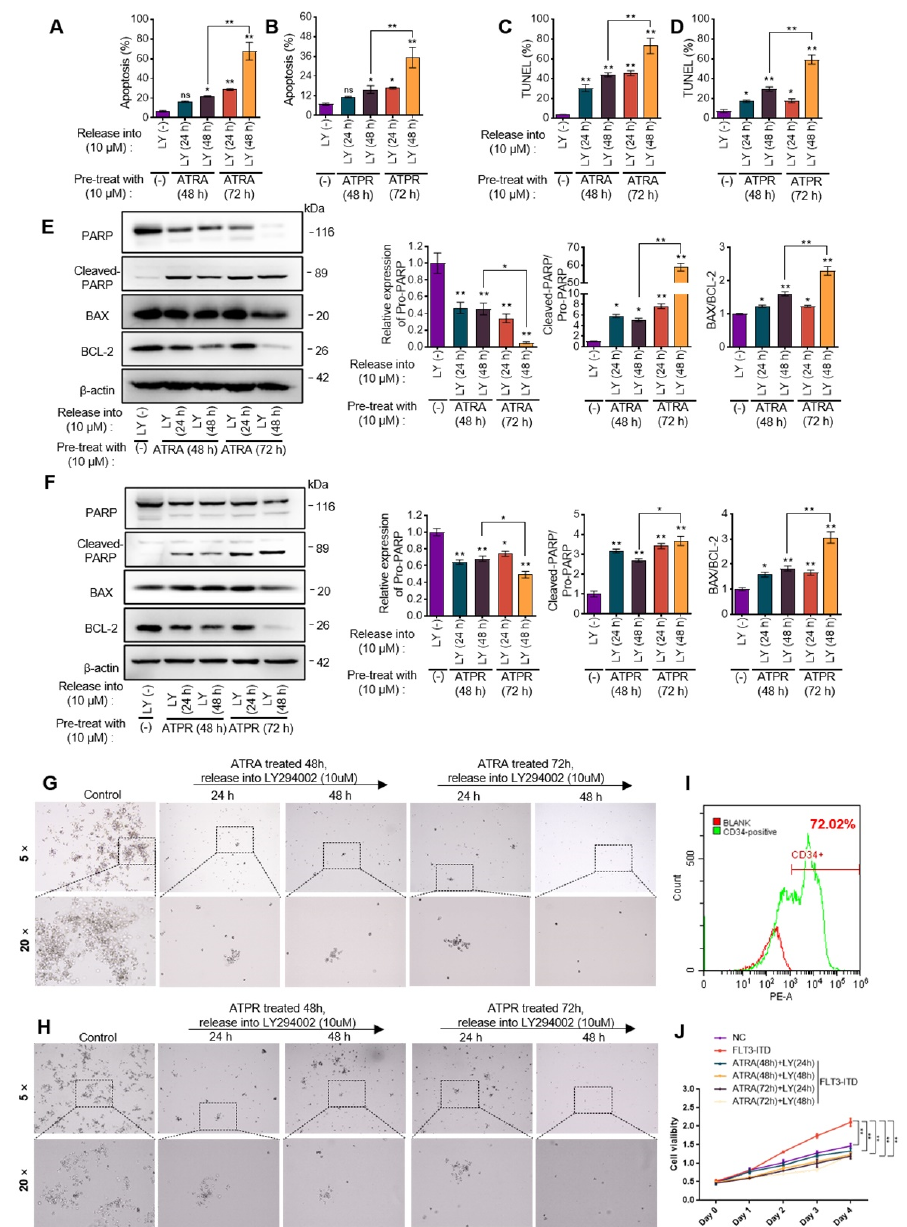
Figure 6. Sequential strategy combing PI3K/AKT inhibitor following ATRA or ATPR eliminated AML cells. The sequential strategy was that Molm13 cells were pretreated with ATRA or ATPR (10 µ M) for 48 or 72 h and then released into LY294002 (10 µ M) for 24 or 48 h. Then, ( A , B ) Cell apoptosis were detected by flow cytometry using an Annexin V-FITC/PI staining kit (( A ) ATRA; ( B ) ATPR). ( C , D ) TUNEL analysis was processed to further measure the degree of cell apoptosis, and flow cytometry was utilized to quantify the cell apoptosis (( C ) ATRA; ( D ) ATPR). ( E , F ) Western blot showing the protein level of anti-apoptotic BCL-2, pro-apoptotic BAX, PARP, and its cleavage (( E ) ATRA; ( F ) ATPR). The ratio of BAX relative to BCL-2 and cleaved-PARP relative to pro-PARP were used to assess cell apoptosis. ( G , H ) The self-renewal capacity of Molm13 cells was analyzed by cell clonality and illustrated by colony forming unit (CFU) assay (( G ) ATRA; ( H ) ATPR). ( I ) The sorting efficiency of the CD34+ HSPCs was assessed by the proportion of CD34-positive cells and detected by flow cytometry. Blank, cells not incubated with CD34 antibody. ( J ) Effect of sequential strategy combing ATRA and LY294002 on FLT3-ITD-driven rapid cell growth/proliferation was measured using CCK-8. ns, not significant; * p < 0.05, ** p <